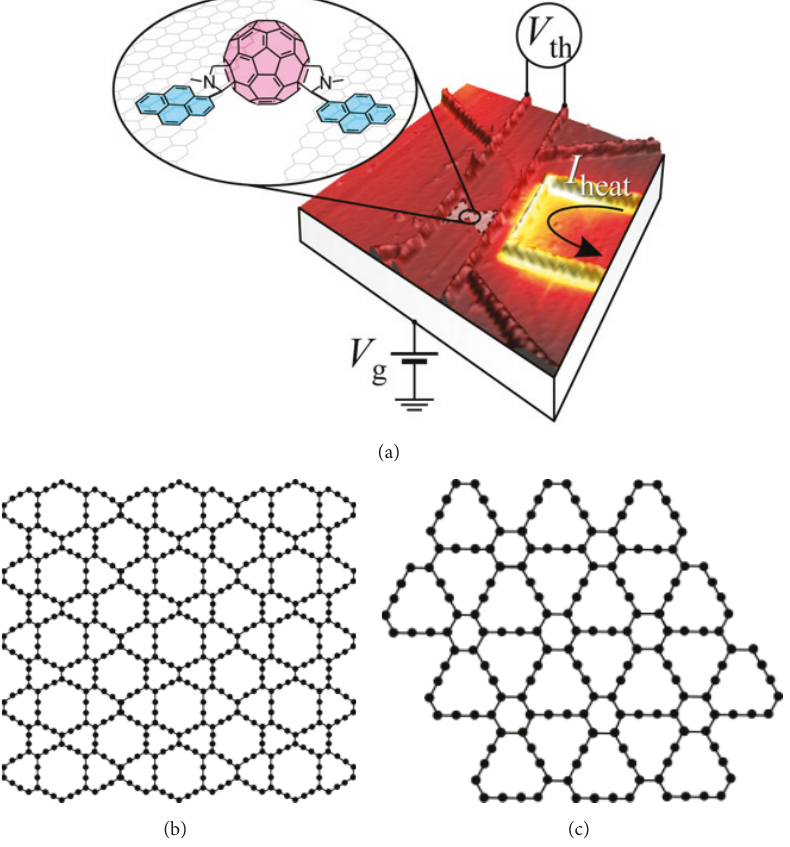
Figure 10: (a) Schematic of the graphene-fullerene junction TE device fabricated by Gehring et al. ((b) and (c)) Atomic structures of 𝛽 - graphyne (b) and 𝛾 -graphyne. Panel (a) is reproduced with permission